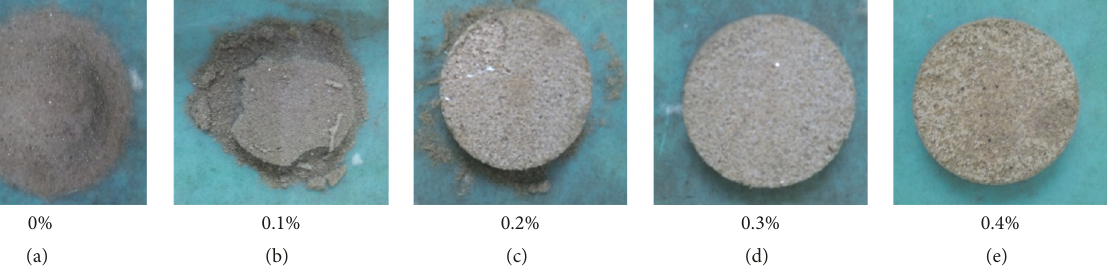
Figure 5: The specimen failure pattern in water stability